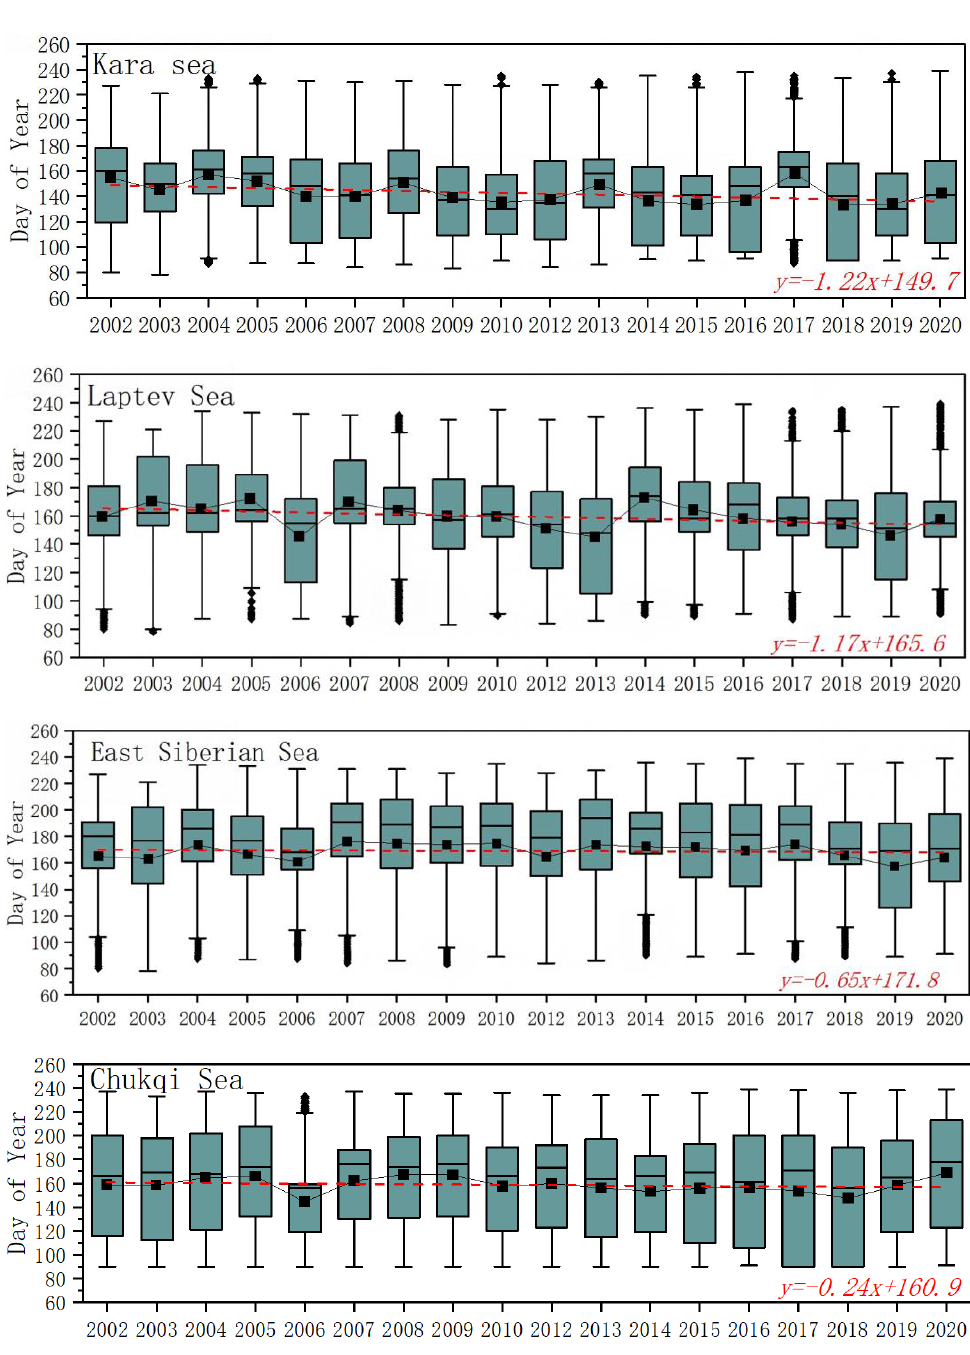
Figure 16. Temporal distribution of sea ice break-up dates in the Kara Sea, Laptev Sea, East Siberian Sea, and Chukchi Sea in the Arctic from 2002 to 2020, which shows an earlier break-up for all selected sea areas. The standard errors were 0.35, 0.38, 0.26, and 0.30, respectively, and passed the significance test ( p < 0.05).